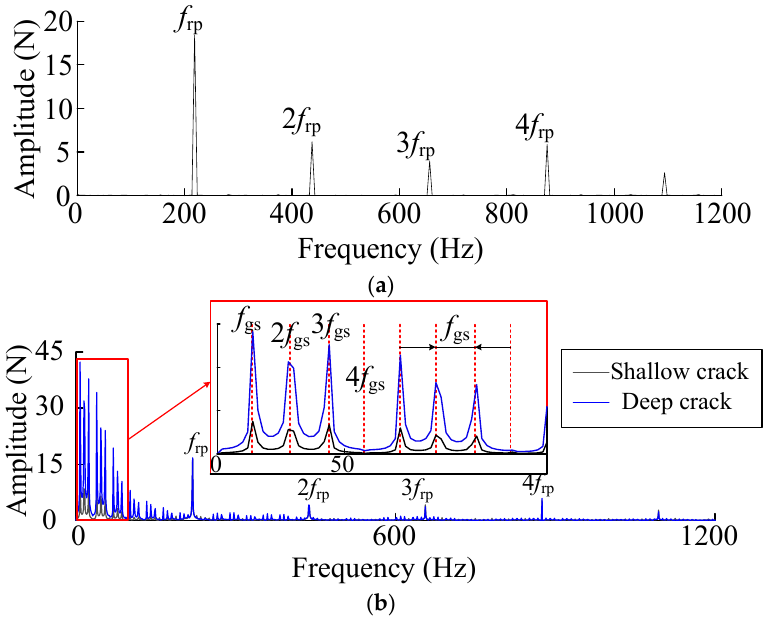
Figure 9. ( a ) Frequency domain history of the normal dynamic loads. ( b ) Comparison diagram of the dynamic excitation frequency domain under crack